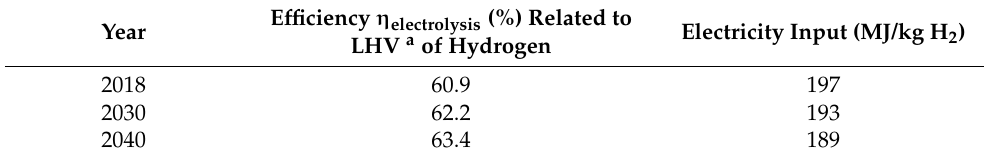
Table 2. Efficiency of electrolysis process based on Prognos (2020) [36].